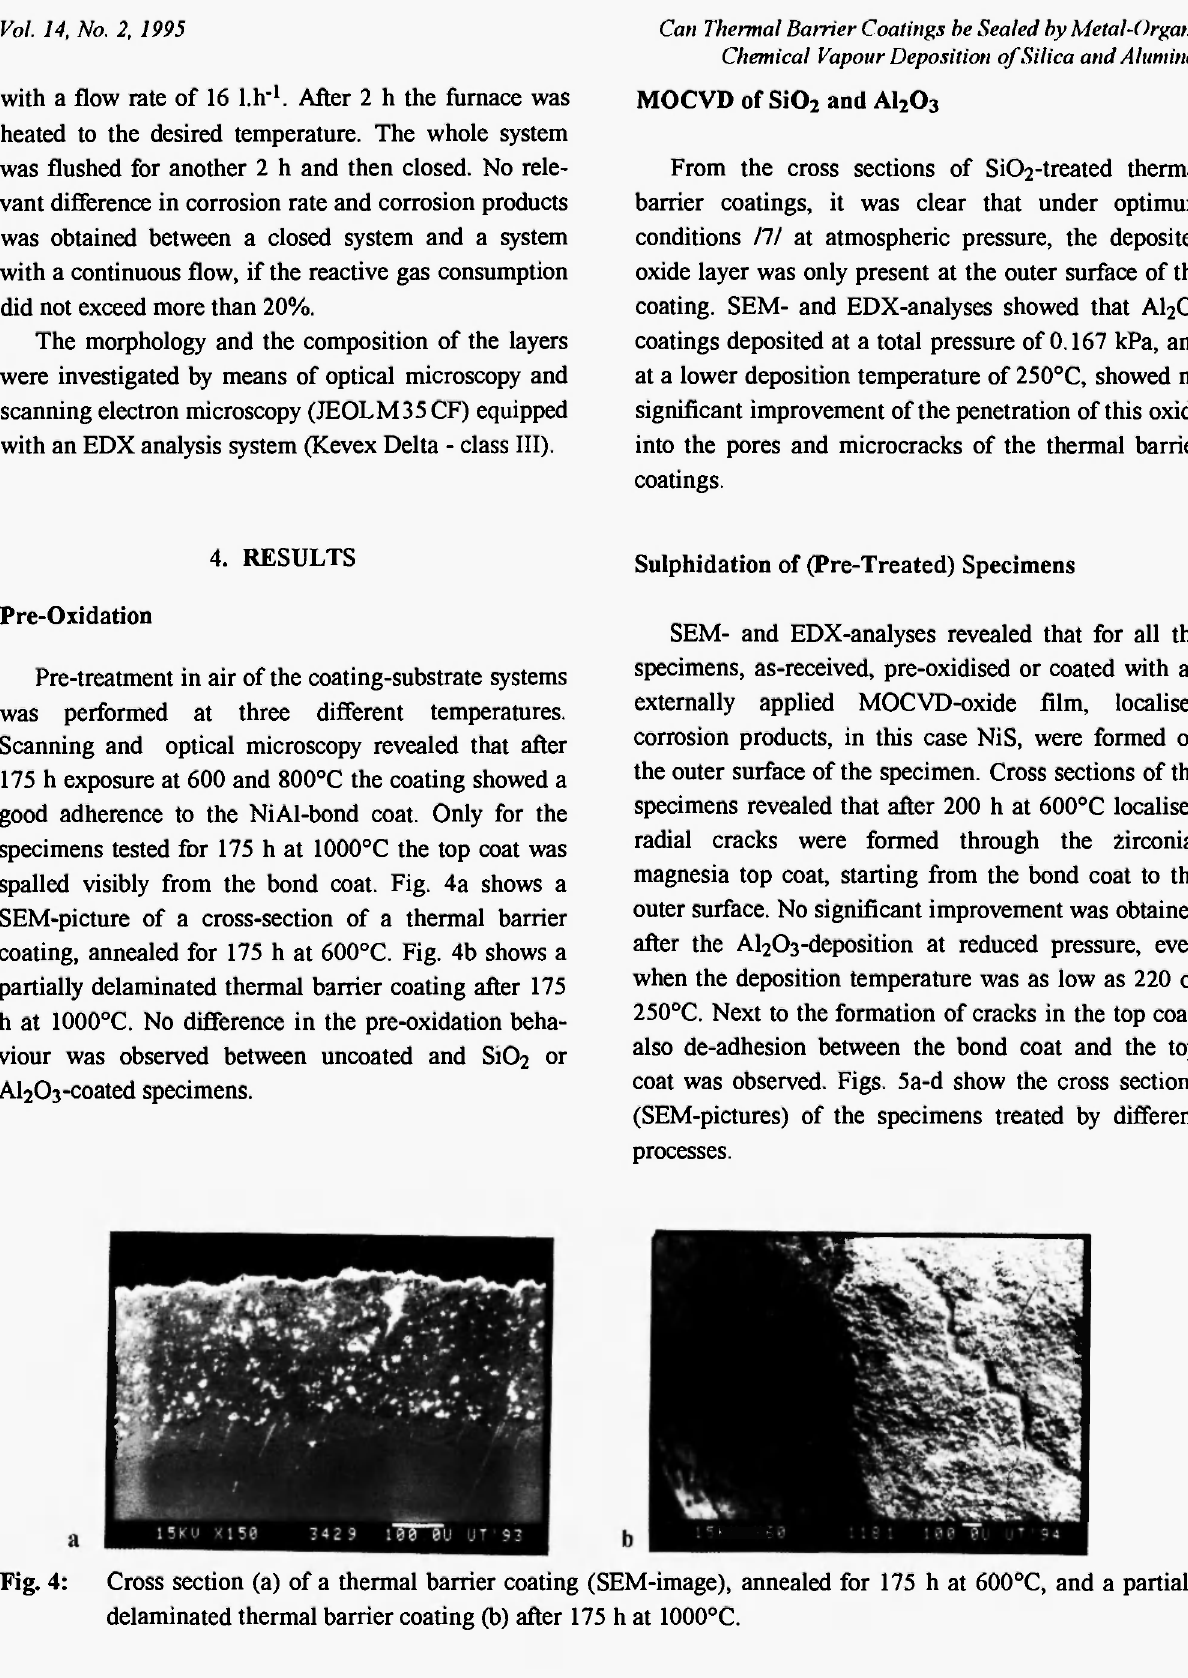
Fig. 4: Cross section (a) of a thermal barrier coating (SEM-image), annealed for 175 h at 600°C, and a partially delaminated thermal barrier coating (b) after 175 h at